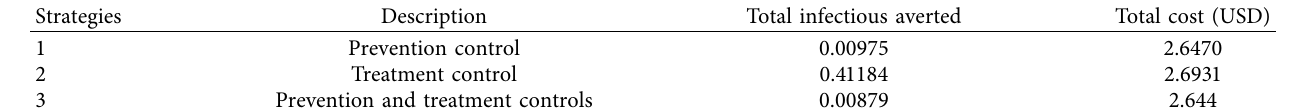
Table 3: Description of controls, infectious averted, and cost.